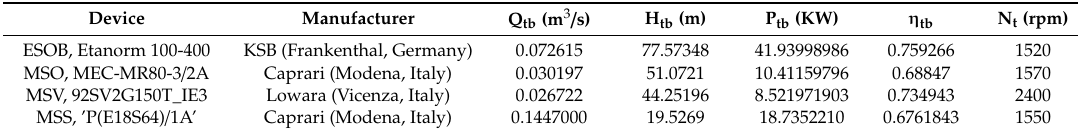
Table 4. Experimental BEP characteristics in turbine mode.